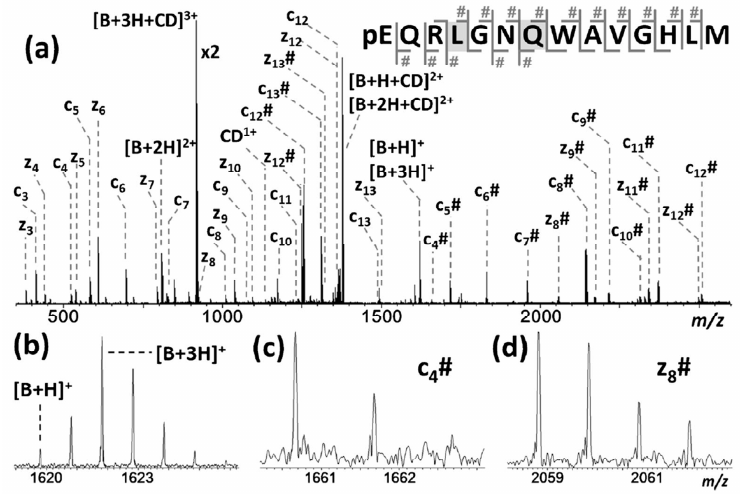
Figure 8. ( a ) Electron capture dissociation (ECD) mass spectrum of the triple-charged β -CD + bombesin peptide ion along with the peptide cleavage map. Multiple c / z fragments were detected and β -CD binding fragments were marked with #. ( b ) The generation of unusual [peptide + 3H] + ions, meaning the hydrogen transfer from the CD to the peptide at the hydrogen bonding position. ( c , d ) The mass spectra of c 4 # and z 8 # ions corresponding to the CD binding site. Reprinted with permission from Reference [162]. Copyright (2015), American Chemical Society.